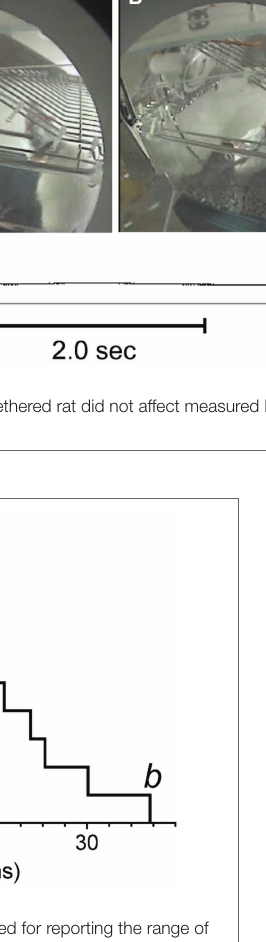
FIGURE 7 | Kaplan–Meier survival curve adapted for reporting the range of latency times prior to onset of seizures while breathing 5 ATA O 2 . Each vertical step indicates the latency time to seizure in a rat after reaching 5 ATA O 2 . Refer to text for definitions of a, b, and